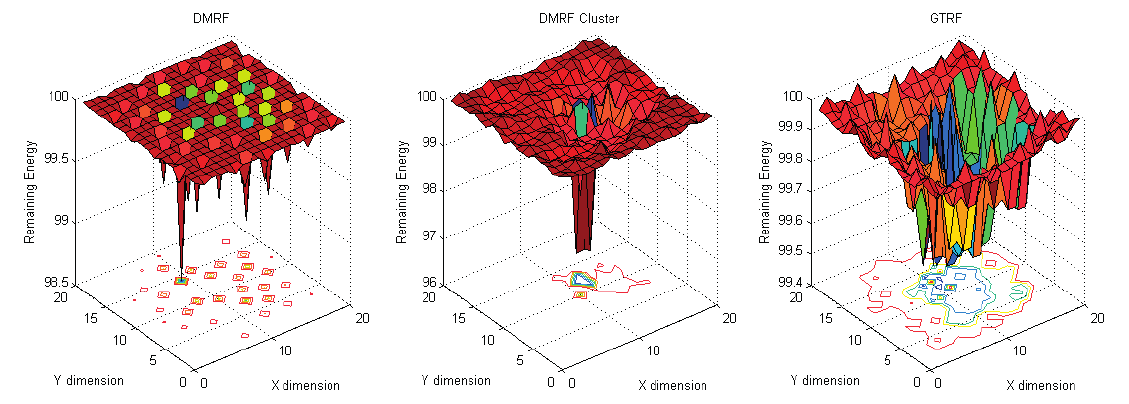
Figure 6. Energy cost with fixed sink with random source with selfish nodes.